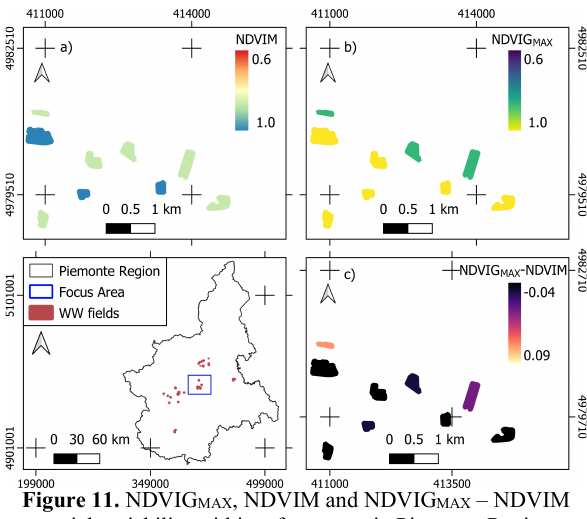
Figure 11. NDVIG MAX , NDVIM and NDVIG MAX – NDVIM spatial variability within a focus area in Piemonte Region. (Reference System: WGS84/UTM 32